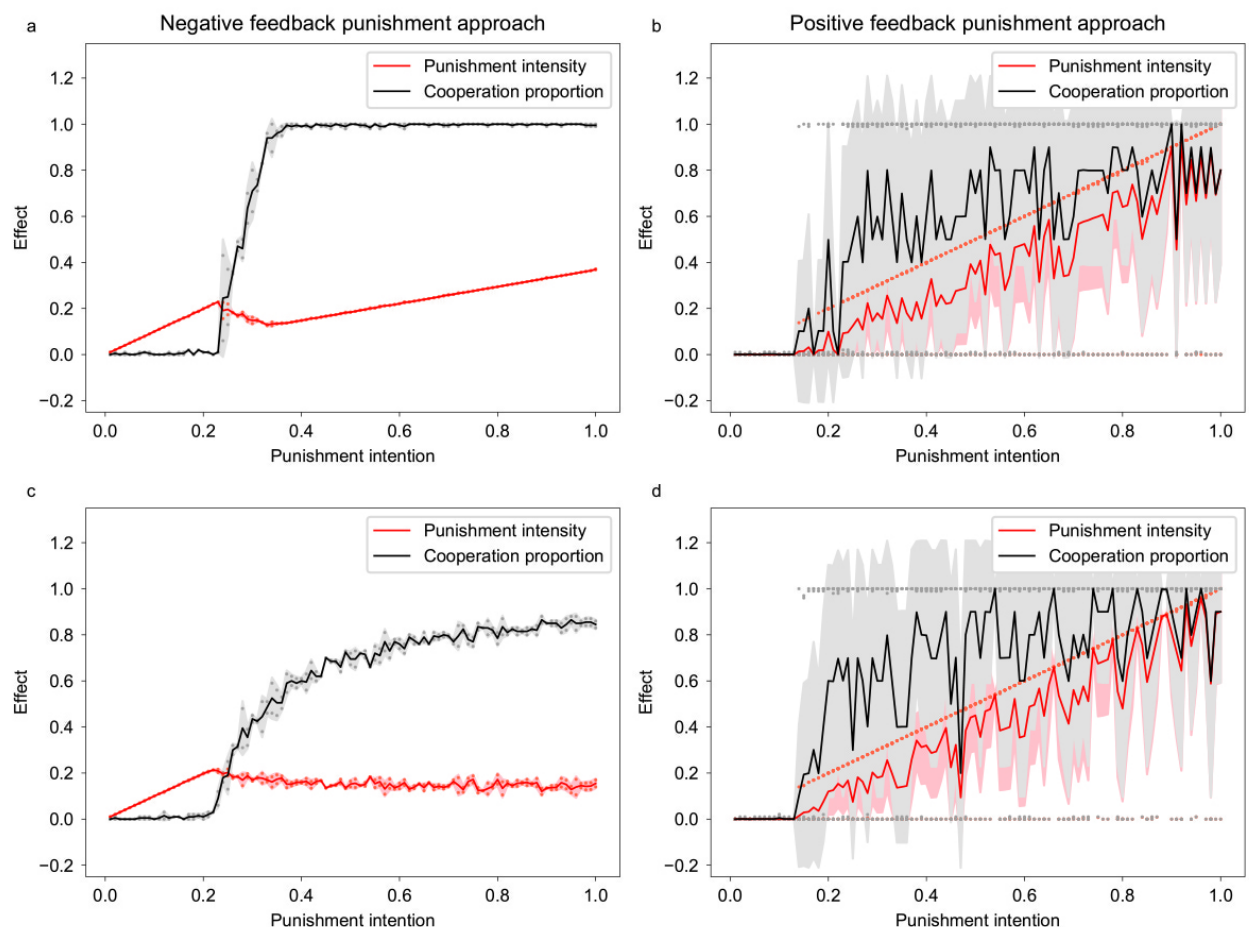
Figure A1. Comparison of different functions in negative and positive feedback punishment ap- proaches. ( a , c ) are the effects of punishment intention on group performance under the negative feedback punishment approach, and ( b , d ) are the results under the positive feedback punishment approach. Red and gray dots represent the punishment intensity and cooperation proportion at the end of each evolution, correspondingly. The solid line and shading indicate the mean and std value over 10 repetitions for each punishment intention. The sampling interval of punishment intention was